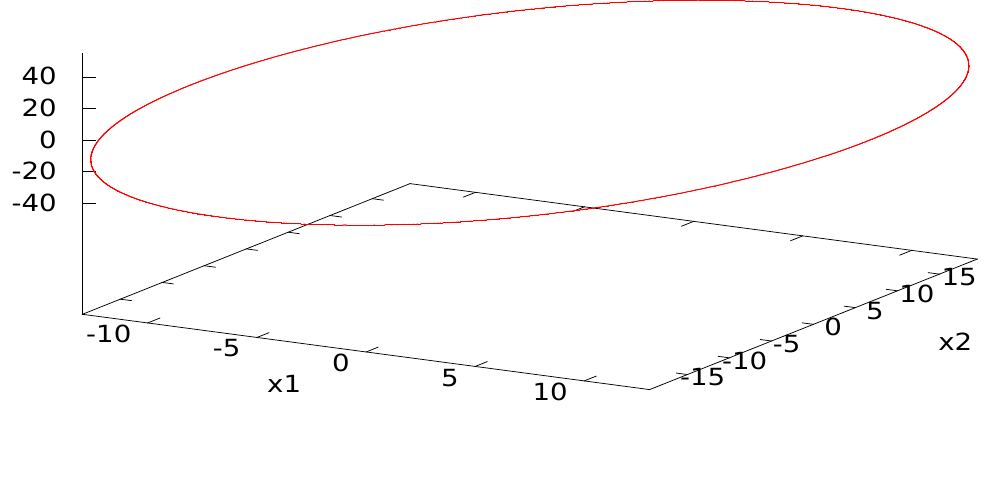
Figure 2. Projection of the cycle of the system (1) with the period T c ≈ 0.3655 into the space x 1 − x 2 − x 4